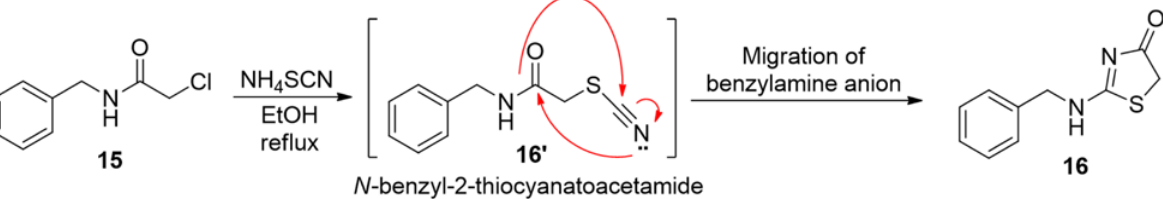
Figure 2. Plausible reaction mechanism for the synthesis of compound 2-(benzylamino)thiazol-4(5 H )-one ( 16 ).